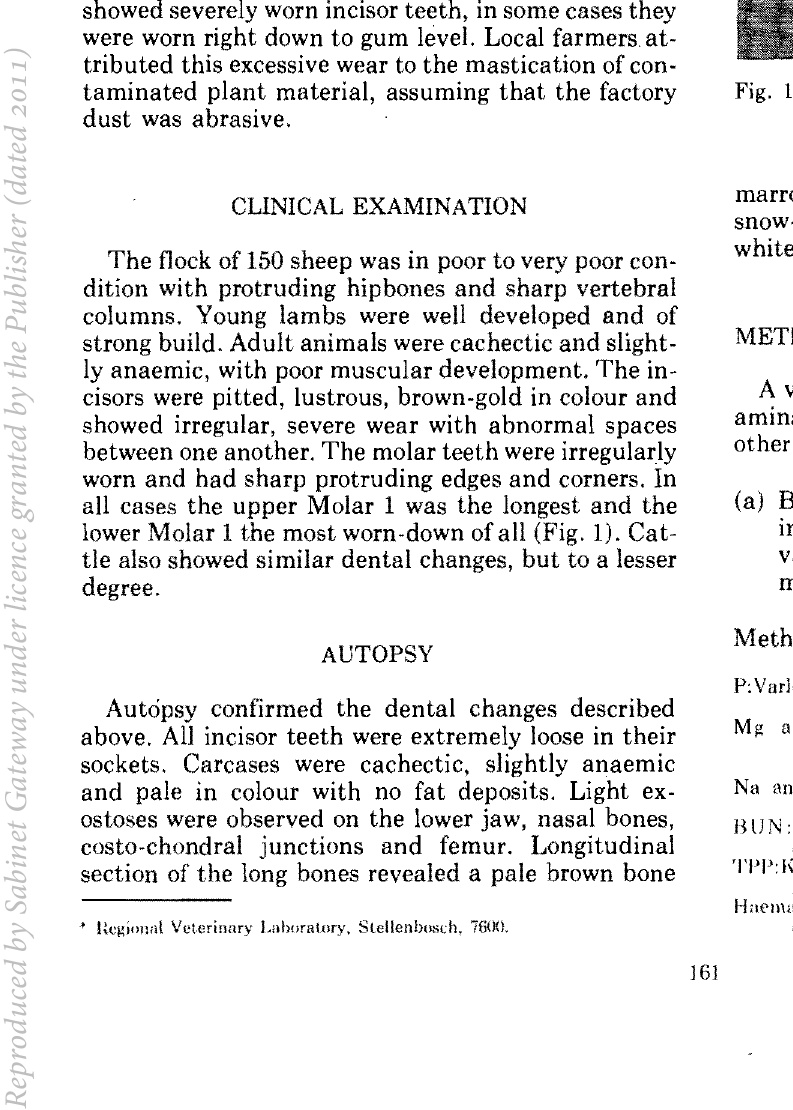
Fig. 1: Irregular wear and pigmentation of the teeth of a sheep. \